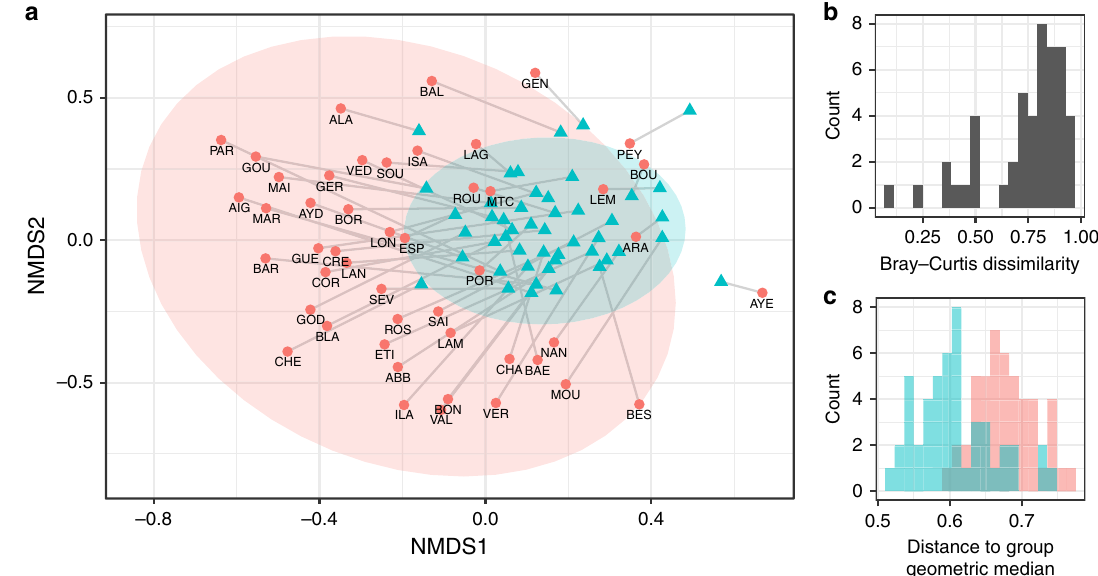
Fig. 2 Multivariate analysis of micro-eukaryotic communities based on OTUs matrix. a NMDS of community compositions of the recent (blue triangles) and past (red circles) samples with 95% con fi dence ellipses represented for each group. Gray lines connect recent and past samples from the same lake. Stress = 0.24. b Distribution of Bray – Curtis index values computed for each lake between recent and past samples. c Distribution of the distances between samples and group geometric median for recent (blue) and past (red)